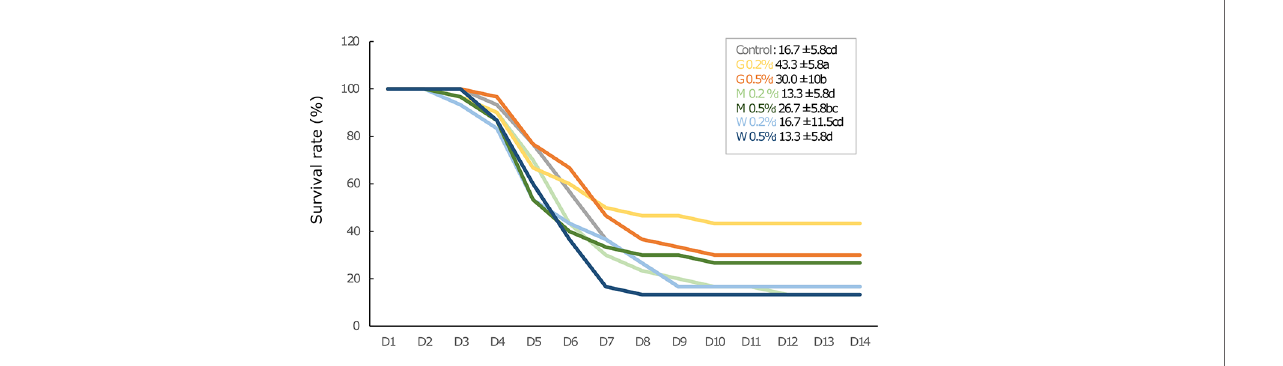
FIGURE 8 | Survival rate pro fi le in rainbow trout juveniles fed with different types of beta glucan at low (0.2% diets) or high doses (0.5% diets) and challenged with Aeromonas salmonicida achromogenes (3.1 × 107 CFU/100g fi sh body weight) for 14 days. Statistical differences, highlighted by letters, are indicated for glucan concentrations in front of 0, 0.2, and 0.5% next to the corresponding plot, for glucan type by letter above the horizontal bar grouping the two doses of the same glucan, for glucan type x concentrations interactions above each box. P values are shown at the bottom of each graph at a given time point (D15, D36,